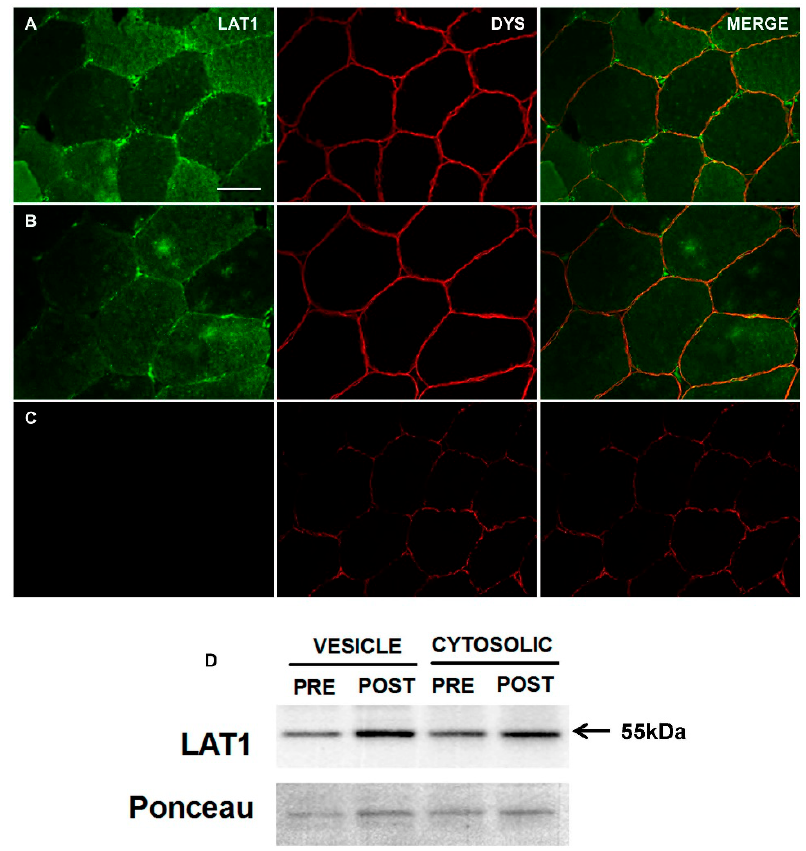
Figure 2. Immunofluorescent detection of LAT1 in human vastus lateralis muscle. Sections were stained with anti-LAT1 antibody (far left panels, green) and then co-stained with dystrophin (middle panels, red) for the identification of the sarcolemma. Representative images from two participants are displayed ( A , B ). Use of a peptide competition assay reduced the signal intensity of LAT1 staining ( C ). A strong positive signal was noted close to the sarcolemmal membrane and possible sites of blood vessels. In addition, a possible fibre type difference in LAT1 staining was noted. Immunoblots for the LAT1 protein displayed bands to be apparent in both giant sarcolemmal vesicles and cytosolic fractions before (PRE) and after (POST) an acute bout of resistance exercise ( D ) ( n = 2). Scale bar in top left panel is 50 μ m and all images were captured at the same magnification.